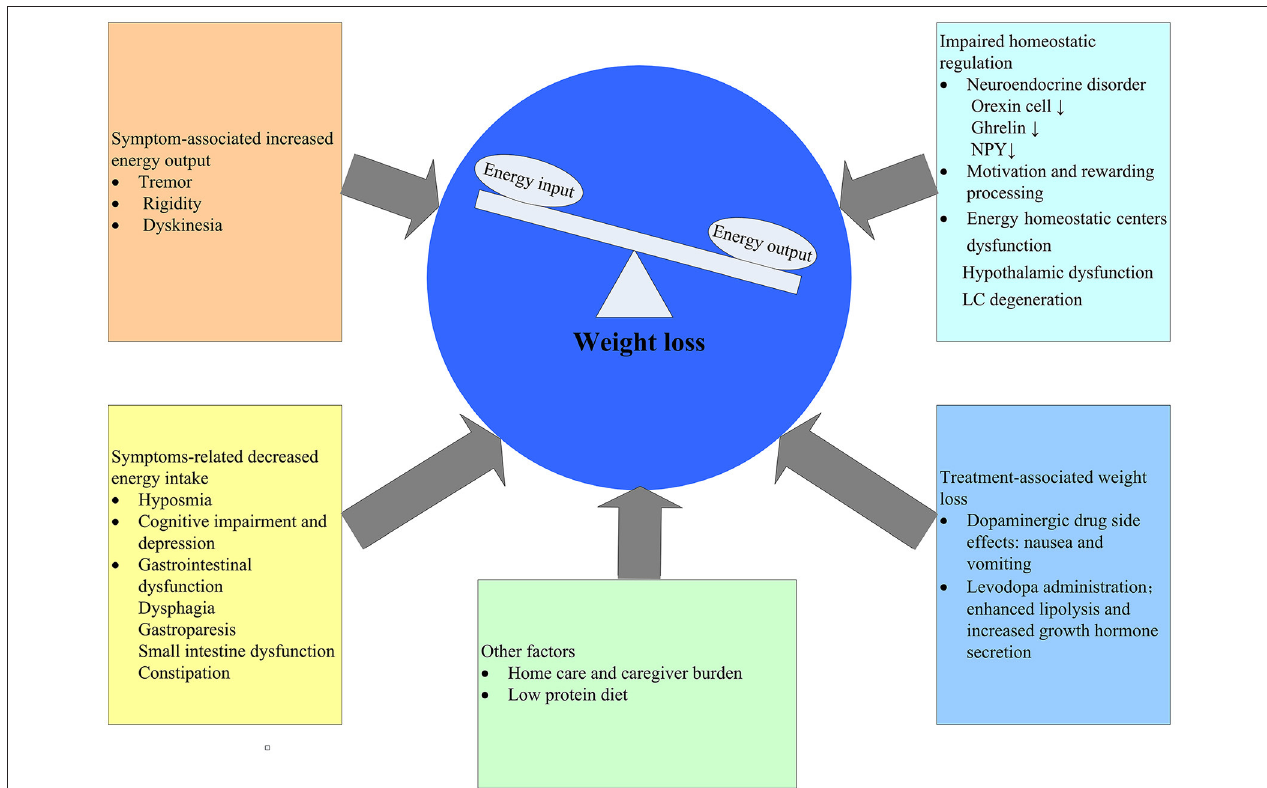
FIGURE 1 | Postulated determinants of weight loss in PD. NPY, NeuropeptideY; LC, locus